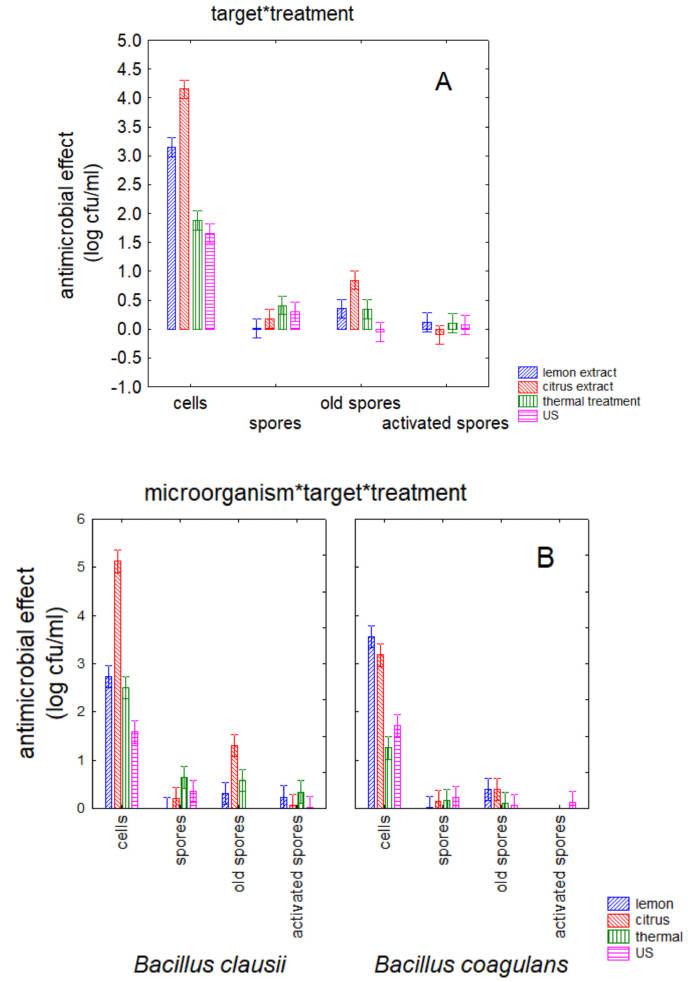
Figure 2. Decomposition of the statistical hypothesis for the e ff ect of interactive terms. Bars denote 95% confidence intervals. ( A ) target × treatment; ( B ) microorganisms × target ×